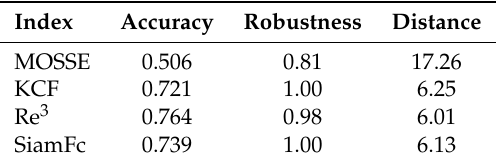
Table 2. Tracking results with different methods on the simulated SAR